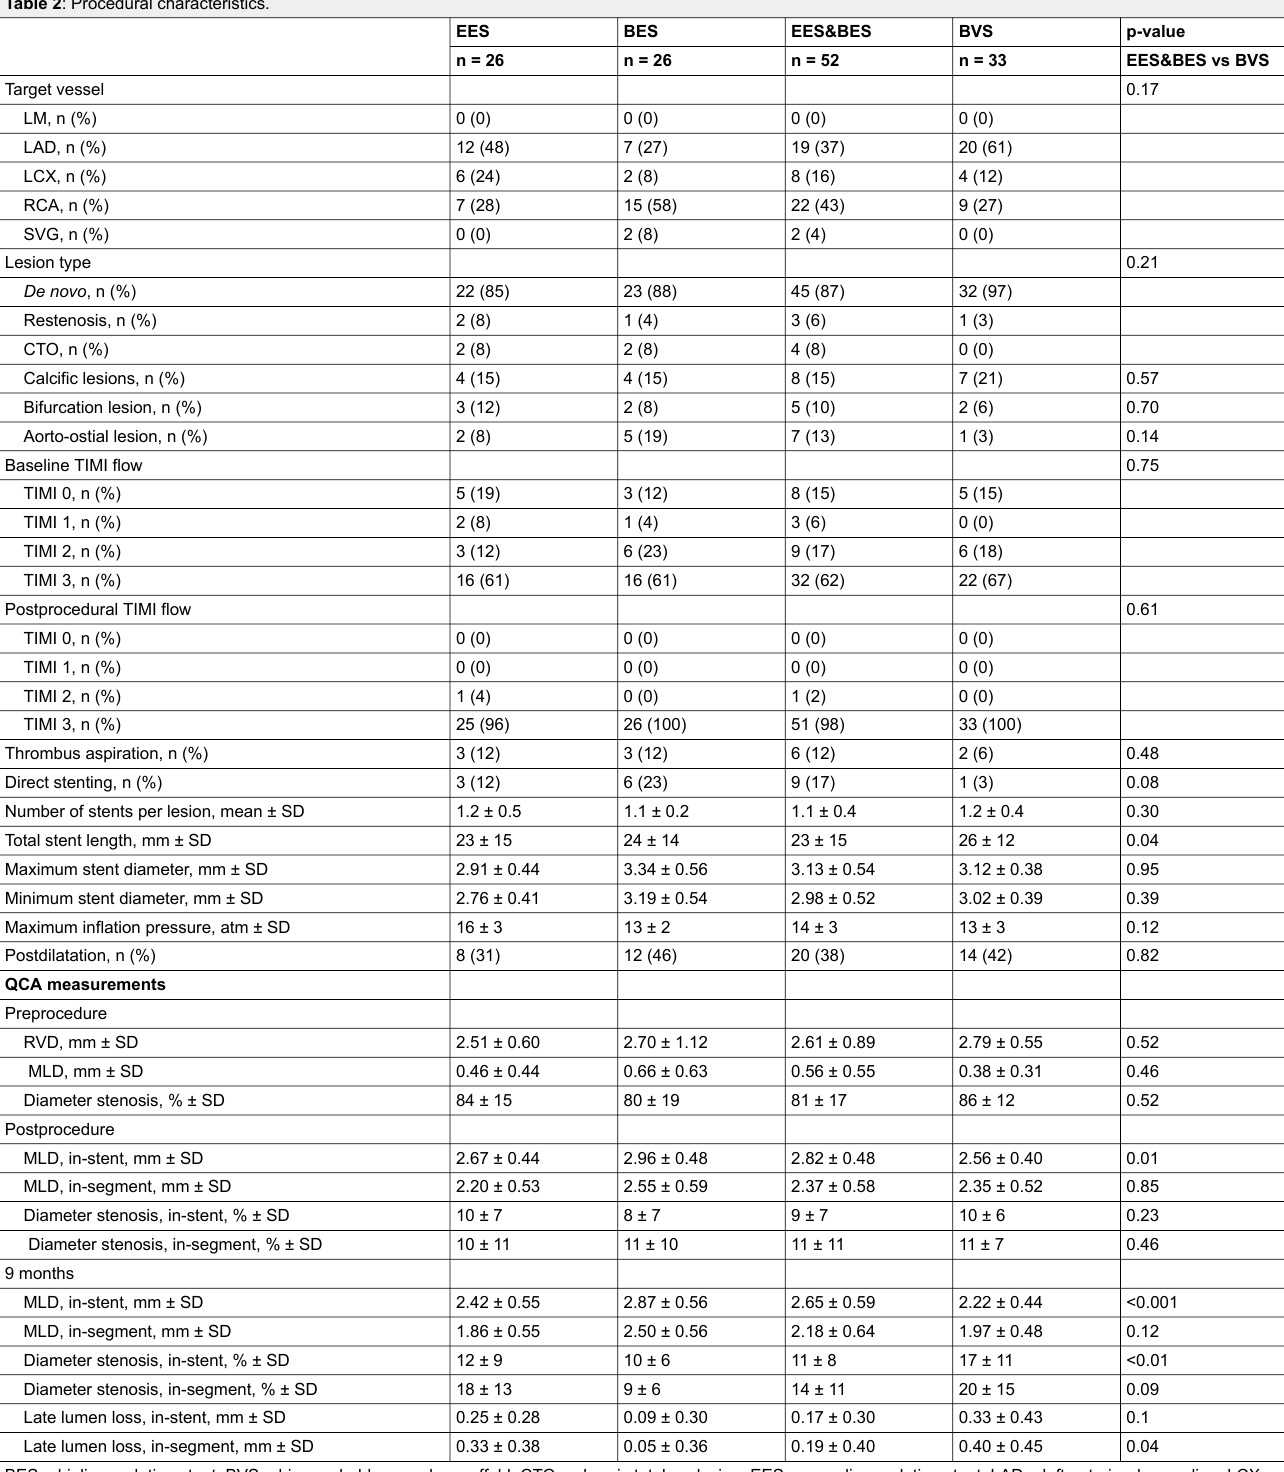
Table 2 : Procedural